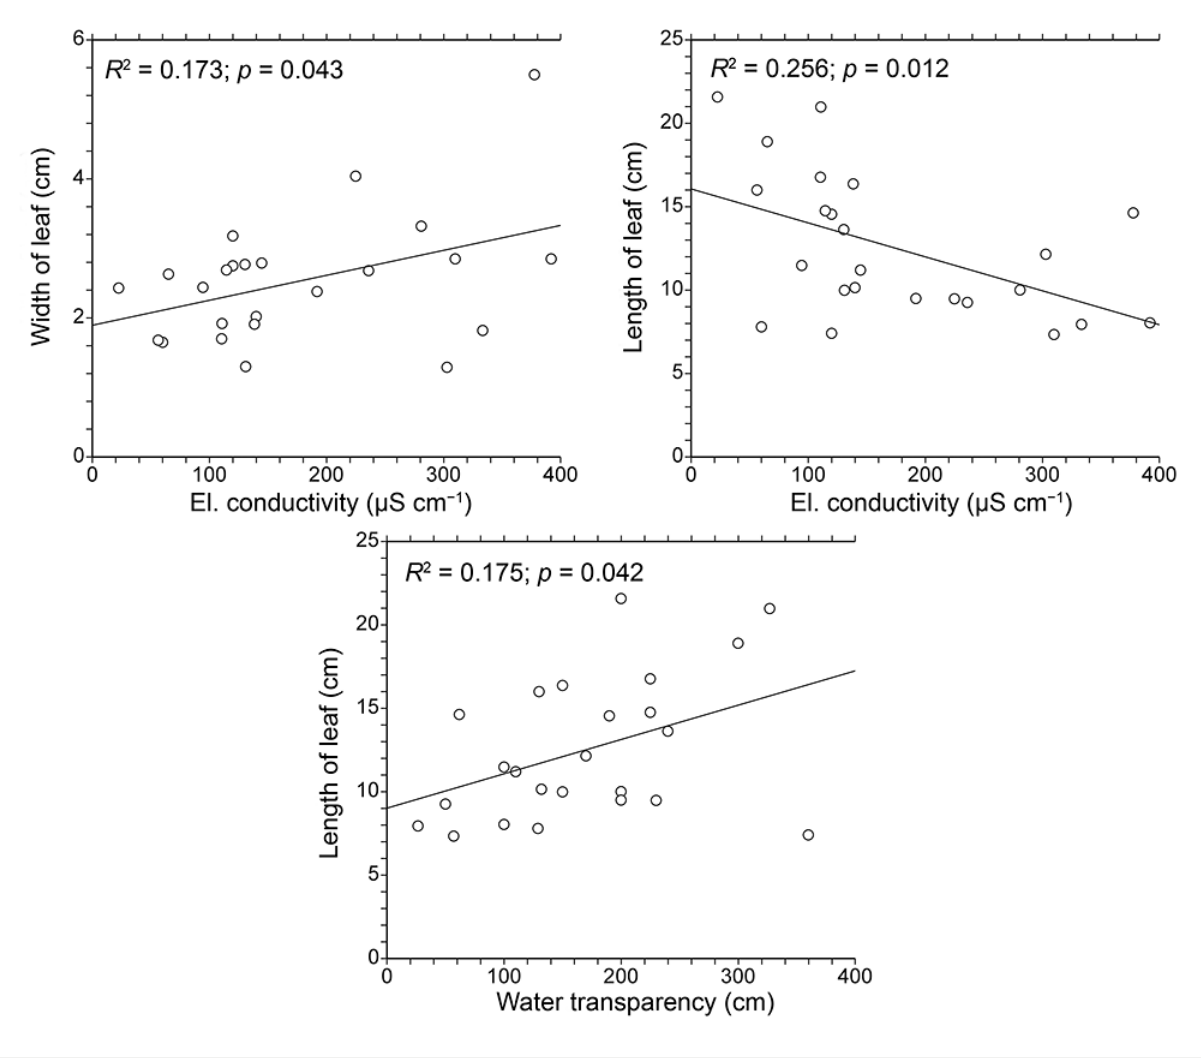
Figure 6 Linear regression between site conditions ( x axis) and morphometric parameters ( y axis), only cases where the regression model was statistically significant are